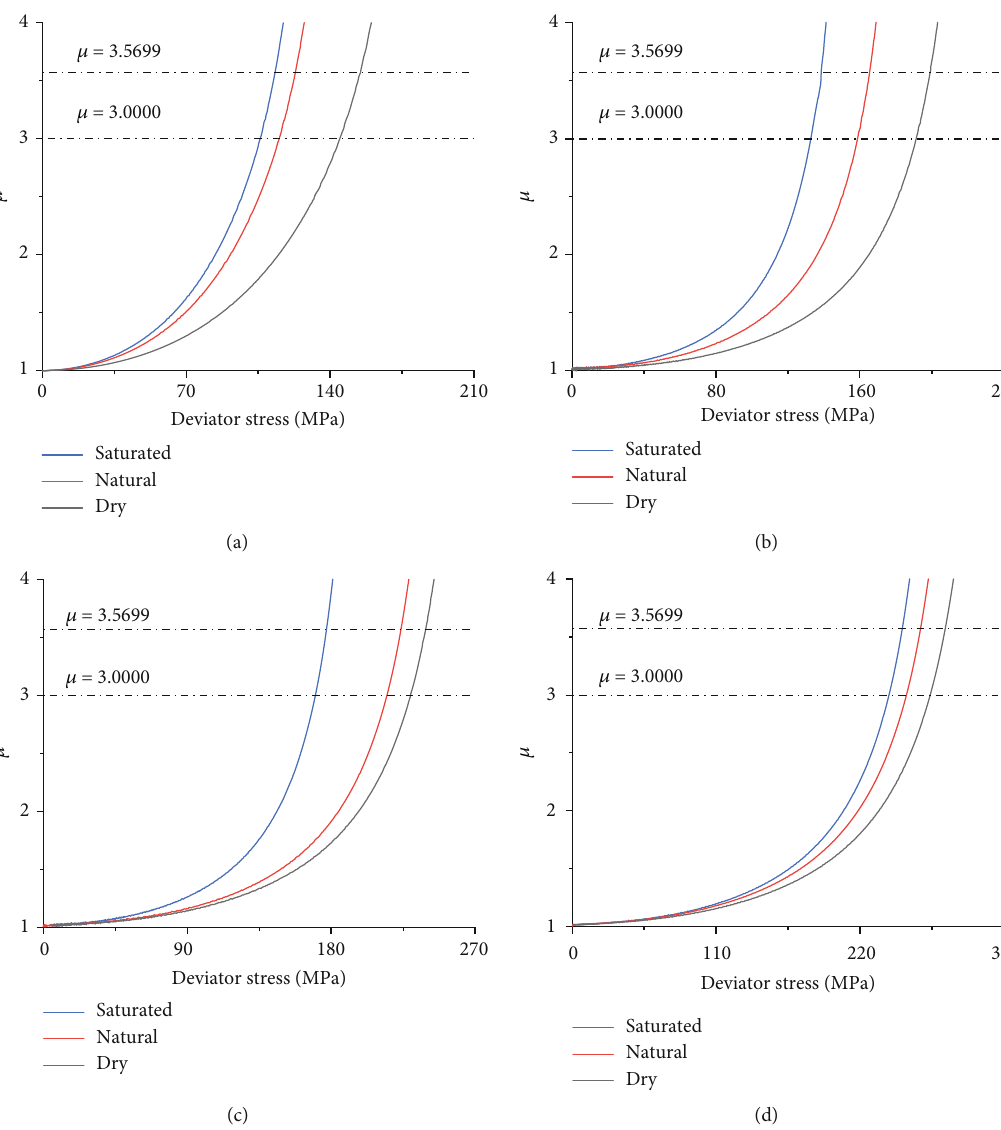
Figure 13: Evolution curve of μ value with deviator stress under di ff erent con fi ning pressure and water content state: (a) σ = 5 MPa; (c) σ = 10 MPa; (d) σ = 20 σ 3 3 3